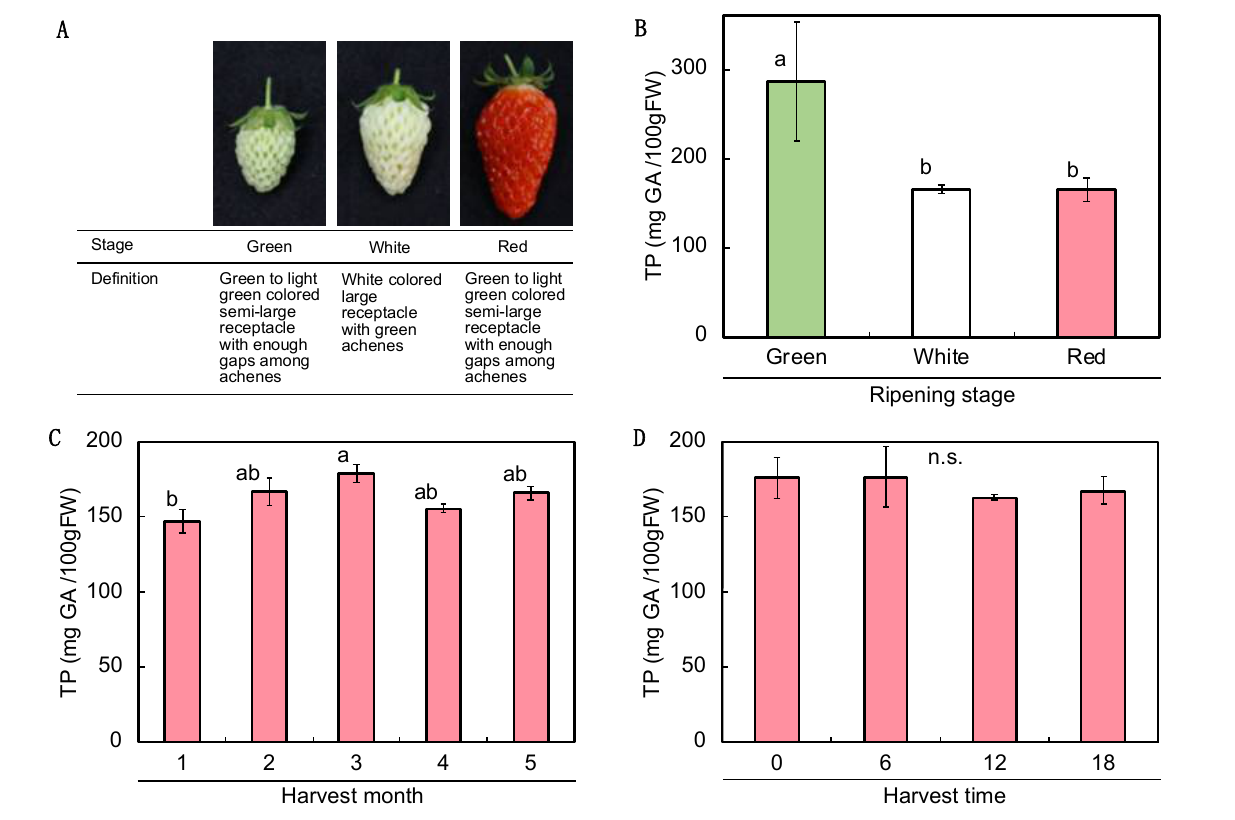
Figure 1. Total polyphenol contents in non-treated strawberry fruits during the ripening stages and under the different harvest conditions. Strawberry was grown by a container culture in a glass green house. Fruit ripening stages in strawberry ( Fragaria × ananassa , cv. ‘Akihime’) were defined as Green, White, and Red ( A ). Total polyphenol contents in fruits were measured at different ripening stages ( B ), and various harvest months ( C ) or times ( D ). Different letters in each graph show significant ( p < 0.05) differences with Tukey’s test ( n = 4, r = 2).